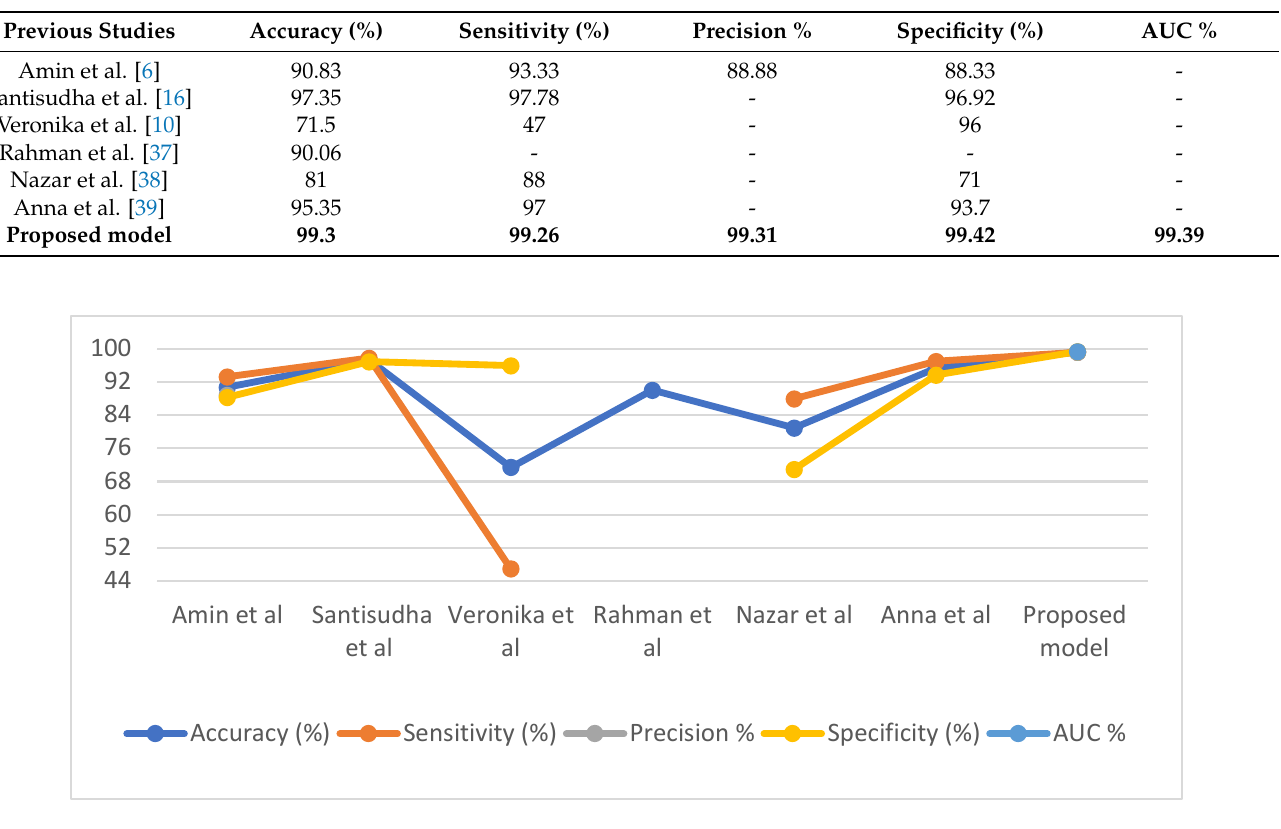
Table 7. Comparison of our results with previous related studies.